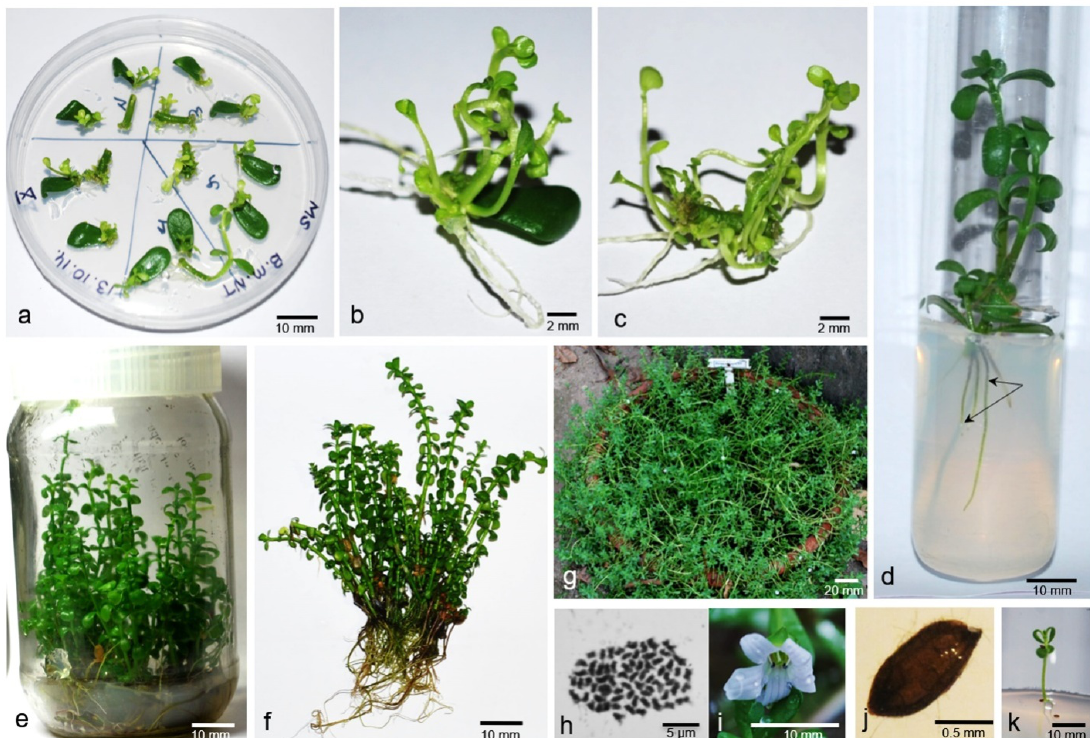
Figure 1. Micropropagation of B. monnieri in MS basal medium. ( a ) adventitious shoot induction in leaf and internode explant after 3 weeks of culture, ( b ) and ( c ) shoot proliferation after 6 weeks of culture, ( d ) rooted micro shoots, ( e ) rooted micropropagated plants from single leaf explant, ( f ) rooted plantlets prior to transfer to soil, ( g ) Acclimatized plants with flowers after 6 months of field transfer, ( h ) somatic metaphase plate in root cell showing 2n = 64 chromosomes. ( i , j ) flower, seed respectively and ( k ) in vitro germination of seed obtained from ex vitro micropropagated plants.